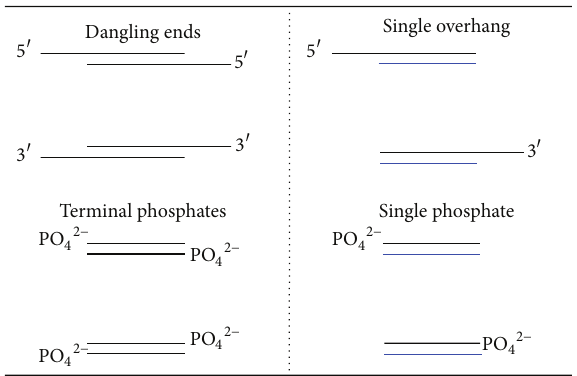
Figure 3: Structural differences in the design of some previously used substrates (left) and herein (right) in characterizing the thermodynamic contribution of a single-stranded DNA region or terminal phosphate (PO 42− ) on the stability of the core dsDNA. Oligonucleotides designed for dangling ends and terminal phos- phates are self-complementary, while the evaluation of a single over- hang or phosphate does not require self-complementary sequences.